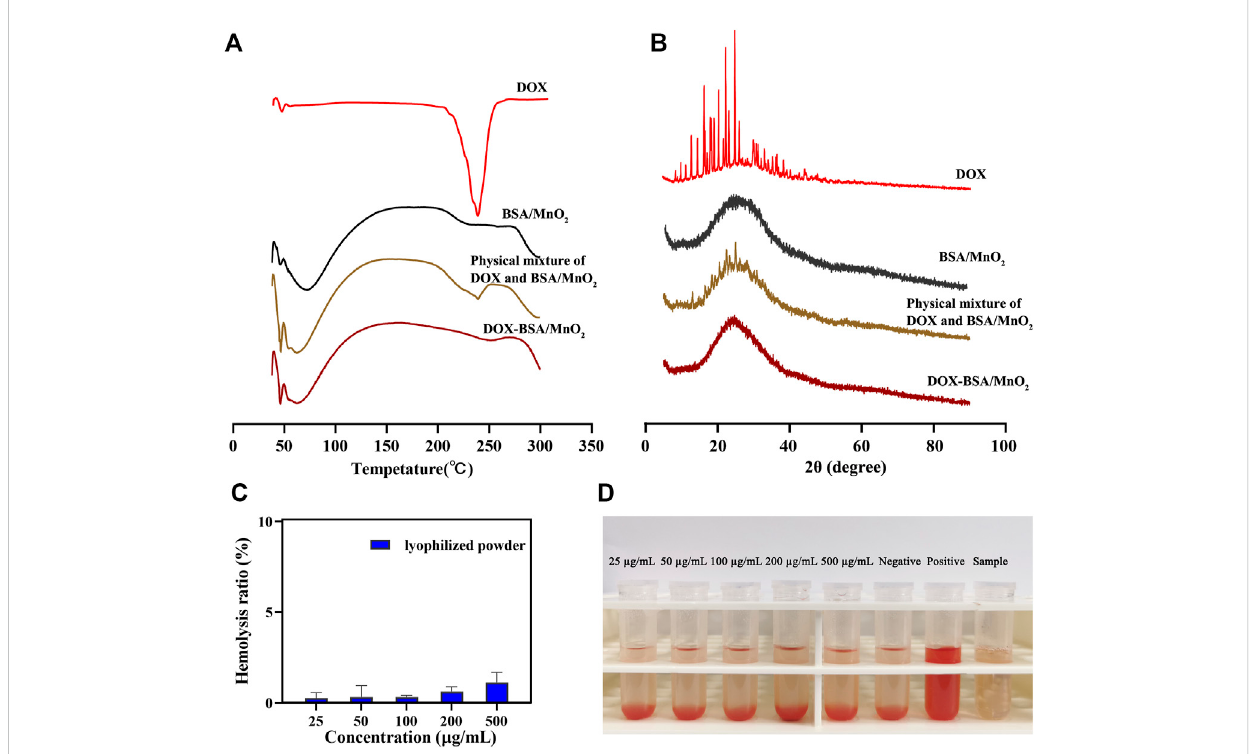
FIGURE 1 Characterization of NPs. (A) Differential scanning calorimetry and; (B) X-ray diffraction patterns of DOX, BSA/MnO 2 NPs, physical mixture of DOX and BSA/MnO 2 NPs, and DOX-BSA/MnO 2 NPs; (C) hemolysis rate of different concentrations of lyophilized powder of DOX-BSA/MnO 2 NPs; (D) images of hemolytic test results of lyophilized powder of DOX-BSA/MnO 2